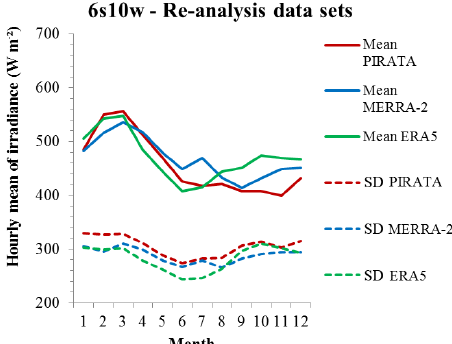
Figure 8. Monthly means (solid lines) and standard deviations (dot- ted lines) of hourly DSIS, in Wm − 2 , from PIRATA measurements (red) and data sets (MERRA-2: blue, ERA5: green) at 6 ◦ S, 10 ◦ W. A difference between red line (measurements) and coloured line (data set) for a given month denotes a systematic error for this month: underestimation if the coloured line is below the red line, overestimation otherwise. For a given month, a coloured dotted line above the red one means that the data set produces too much vari- ability for this month; in the opposite case, the data set does not contain enough